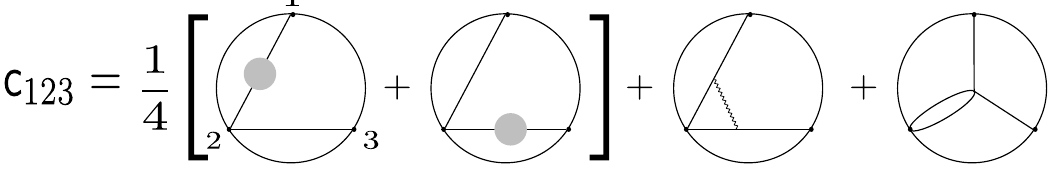
Figure 4 . De(cid:12)nition of the corner contribution c 123 . Although the (cid:12)gures are for the circular Wilson loop, the acutal computation was performed for the straight-line Wilson